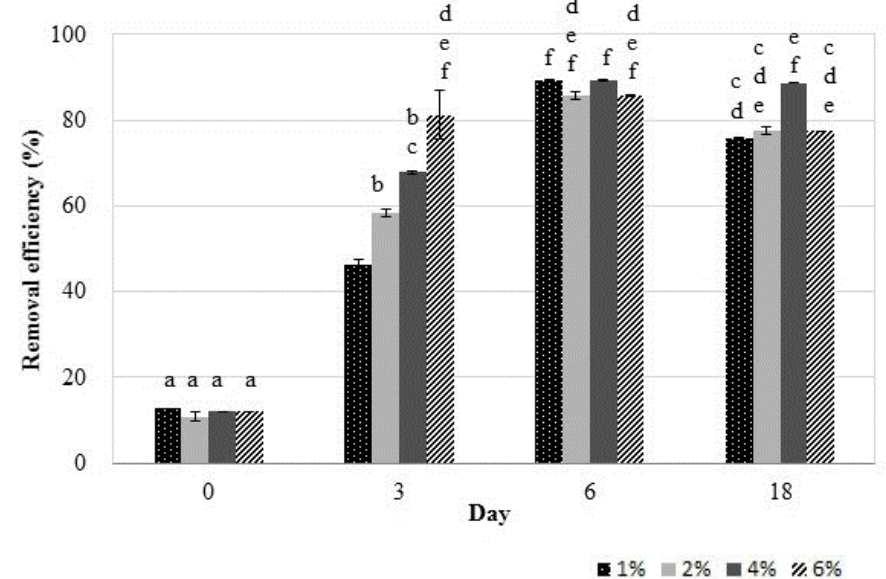
Figure 3. Manganese removal e ffi ciencies of the 2De strain after incubation with di ff erent concentrations of soil at 28 ◦ C for 18 days. The same letter indicates no significant di ff erences among groups (LSD, p < 0.05). Error bars are the standard deviation ( n = 3).